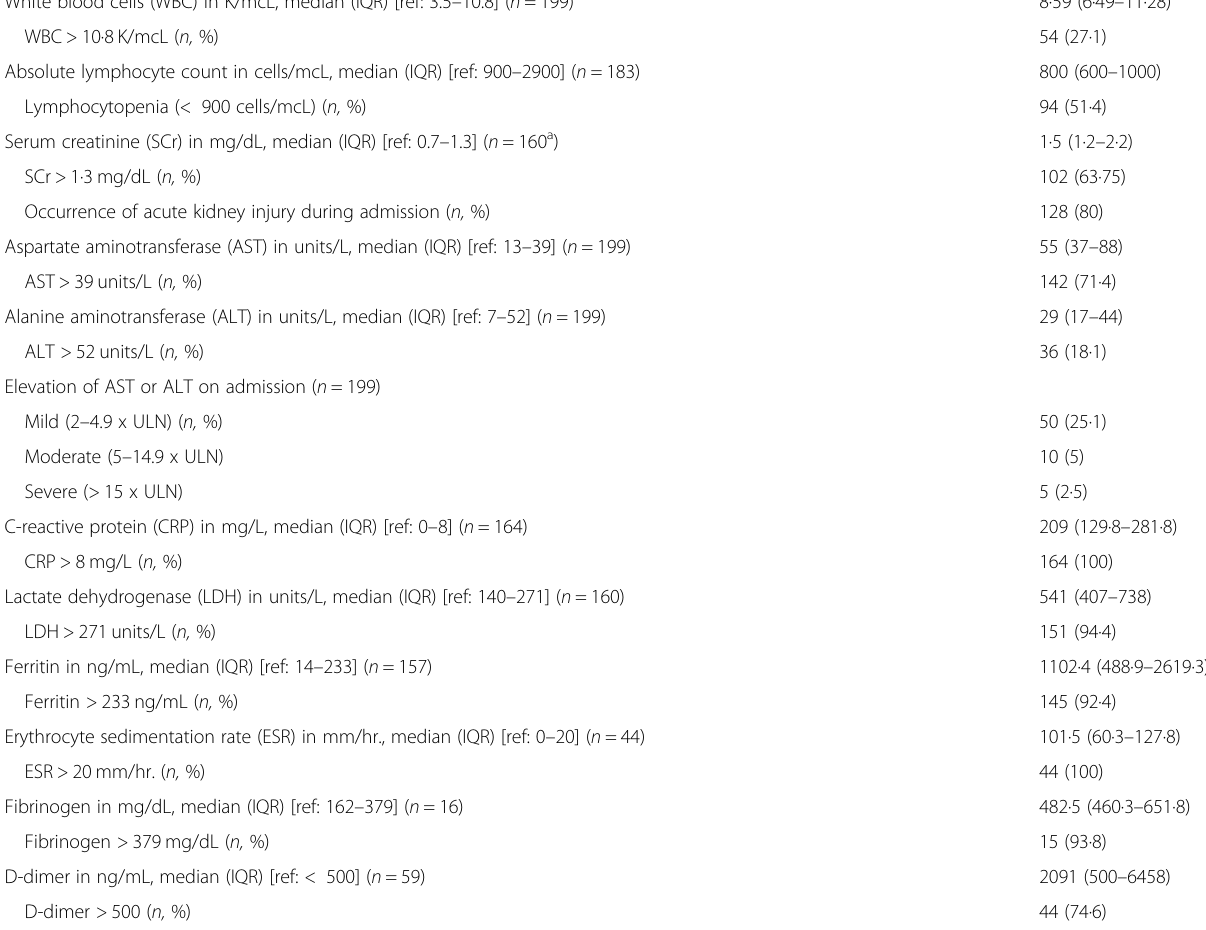
White blood cells (WBC) in K/mcL, median (IQR) [ref: 3.5 – 10.8] ( n = 199)